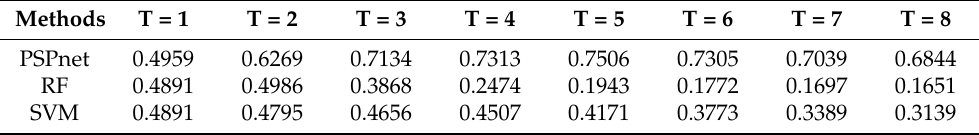
Table A8. The IoU of sample size S = 70 varies with the threshold level